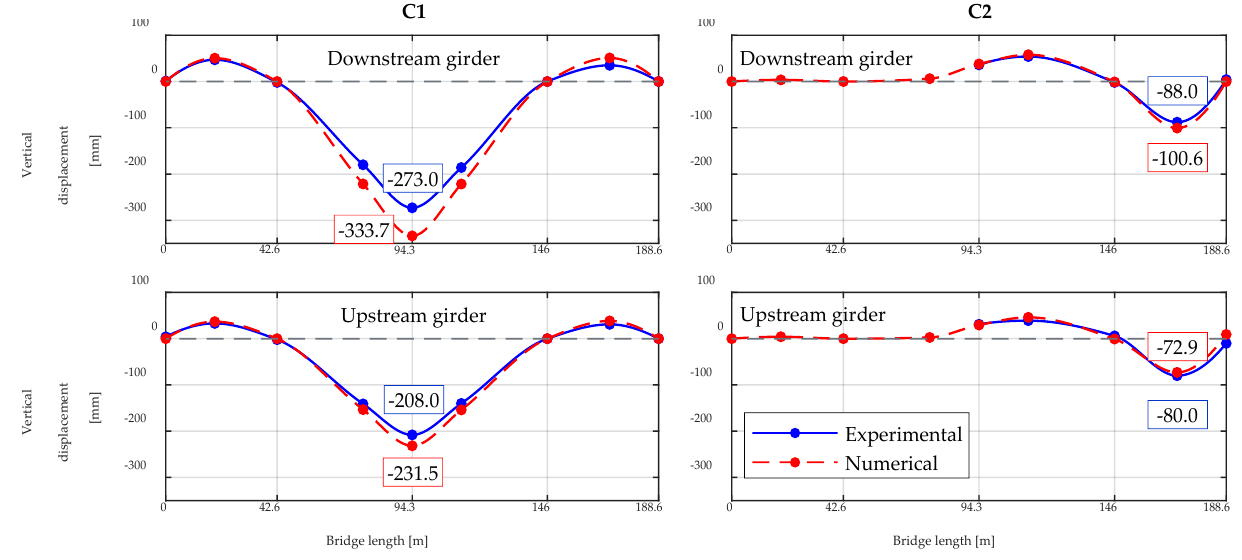
Figure 8. Girder experimental deflections and comparison with the numerical predictions.